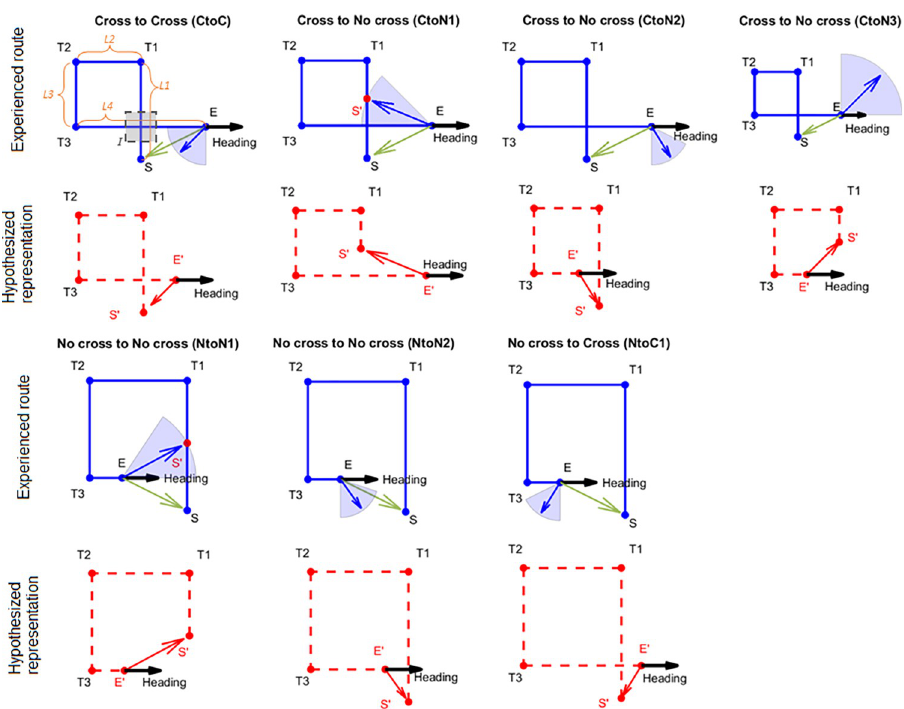
Fig 1. Predicted pointing directions according to each hypothesis in Experiment 1. The example crossed path is Path 3 and the example uncrossed path is Path 7. Blue lines indicate the actual path. Red dashed lines indicate the hypothesized represented path. Green arrows indicate the geometric correct pointing direction at the end of the path (E). Blue shaded areas indicate the actual predicted pointing direction ranges based on the red hypothesized representations immediately below. Blue arrows indicate the mean of the actual predicted ranges for the red hypothesized representations below. Red arrows indicate predicted pointing direction at the represented end (E’). S’: Estimated start position. Top left panel: The grey shaded area shows the hidden intersection area. L1-4: Leg 1–4 according to Euclidean geometry. I: Intersection.